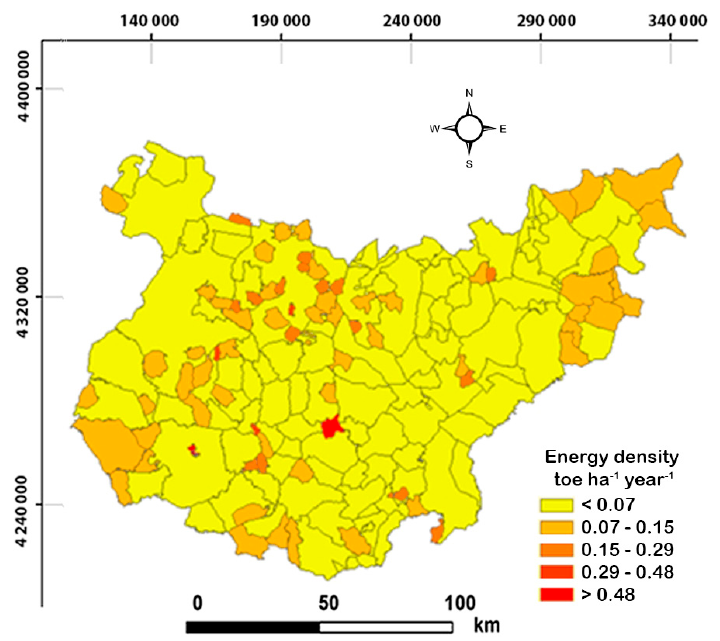
Figure 8. Energy density at municipal level.